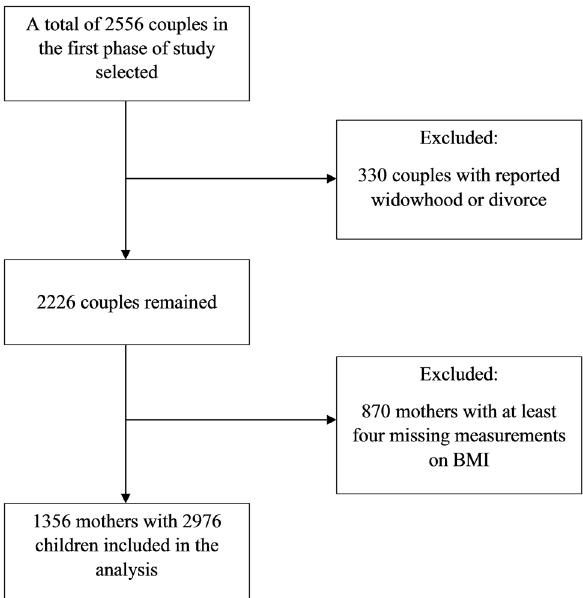
Figure 1. Flowchart of the study